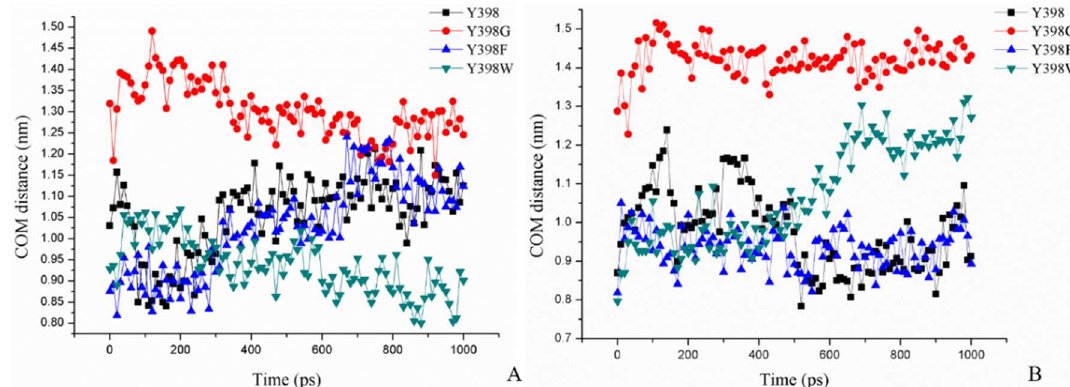
Figure 7. Minimum COM distance between Y/G/F/W398 and M182, ( A ) after the ATChI pulling process, and ( B ) after the Carbofuran-3-hydroxy pulling process.